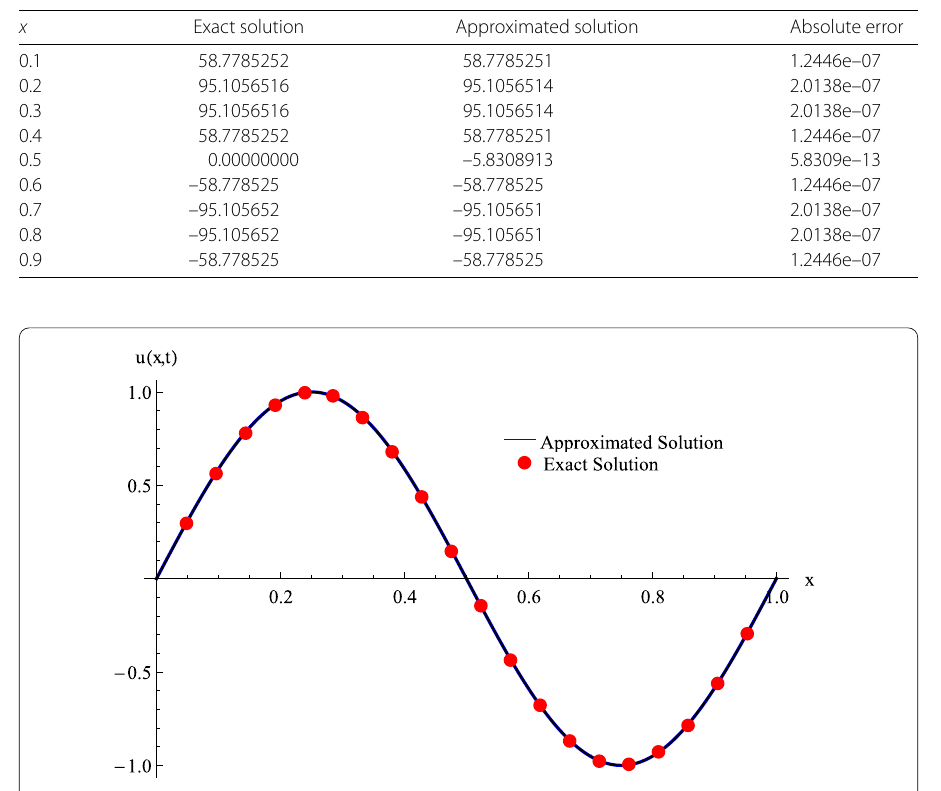
Figure 2 Comparison of approximated and exact solution for N = 16, γ = 0.3, τ = 0.01 of problem-2